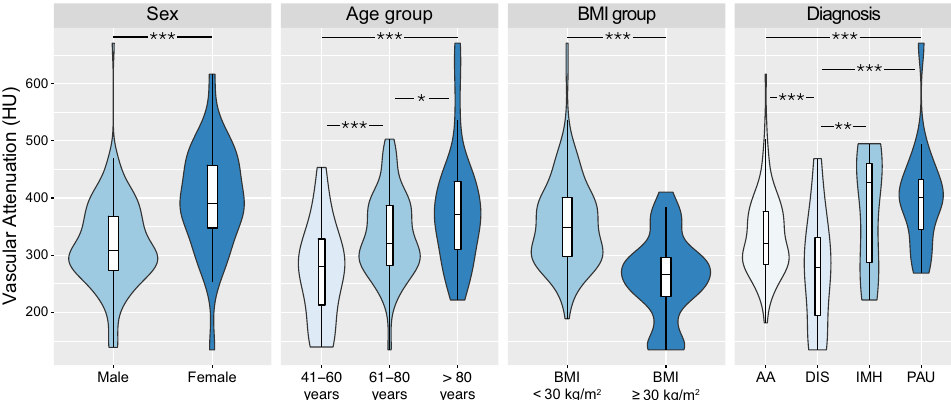
Figure 4. Violin plots and boxplots visualising the subgroup analyses. *** p < 0.001, ** p = 0.002, * p = 0.01. AA = aortic aneurysm, DIS = aortic dissection, IMH = intramural haematoma, PAU = penetrating atherosclerotic